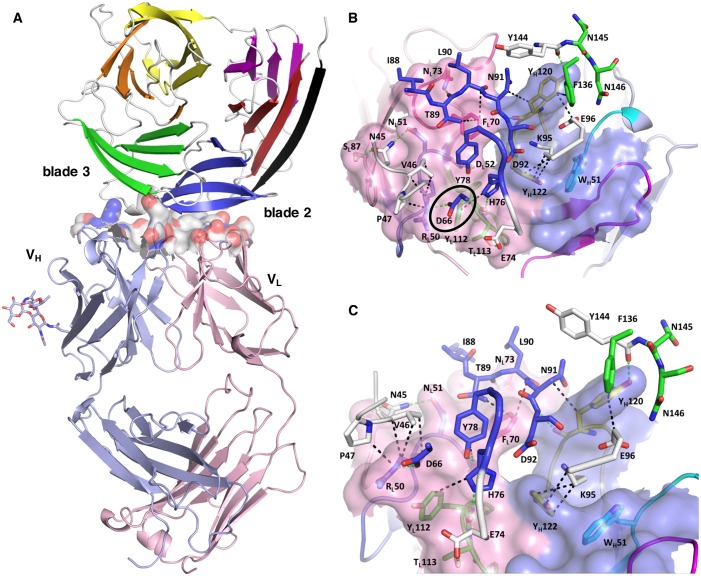
Structure of the PfCyRPA/c12 complex.(A) Overview showing that the majority of the interface is made by interactions between the light chain of c12 and blade 2 of PfCyRPA. (B) Details of the interface viewed from top onto the CDR loops. The light and heavy chain surfaces buried by PfCyRPA are colored pink and blue, respectively. Possible hydrogen bonds and van der Waals interactions are indicated by dashed green and black lines. The CDR loops are color-coded as in Figure 4. The Asp66-Arg50 salt bridge is circled. (C) Close-up of (B).